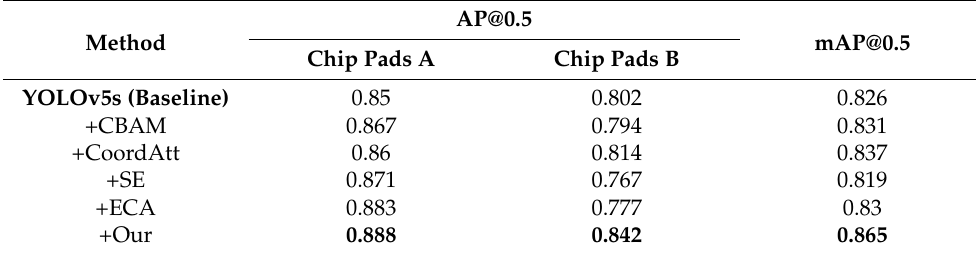
Table 2. Attention module comparison.